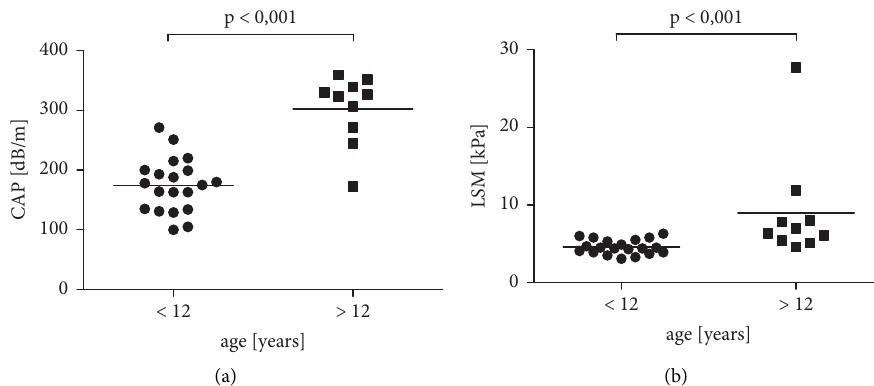
Figure 1: (a) Steatosis assessed by TE. (b) Liver stifness assessed by TE. Steatosis and liver stifness are more pronounced in older patients. p < 0.001.